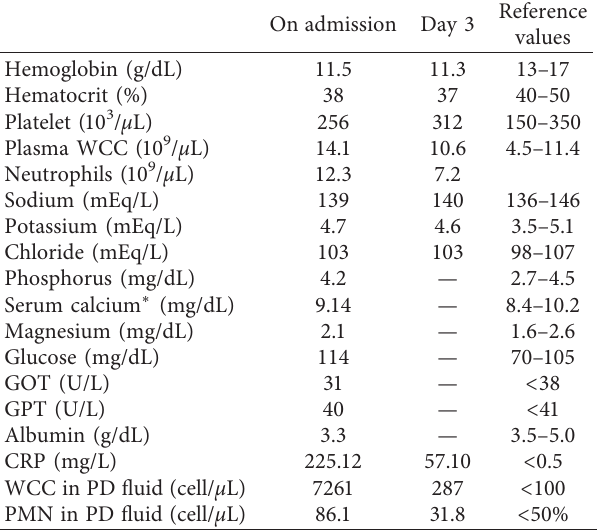
Table 1: Biochemical data on admission and at 72